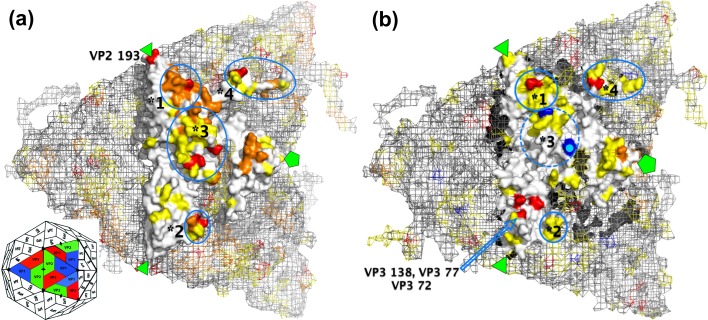
Antigenic sites on serotypes O and SAT1.The molecular surface of (a) serotype O and (b) serotype SAT1 icosahedral protomers is shown using pymol (Schrödinger LLC), with the molecular surface of neighbouring protomers shown as a light grey mesh (refer to inset icosahedral representation of an FMDV capsid for orientation). The molecular surface is white, with known antigenic sites on this serotype in orange (red when they were identified in this study), and known antigenic sites for any other serotype in yellow (see Table 1 and S3 Table for details). The location of the residues on the VP1 βG-βH loop could not be resolved on the serotype SAT1 structure, and so sites on that loop are not shown. Blue highlights mark the beginning (VP1 139) and end (VP1 165, with pale dot) of the disordered area, and the approximate locations of all four surface-exposed regions identified in Table 1 are also circled in blue and marked as before with *1-*4. Residues identified in this study but not in these regions are individually labelled with their positions on the common alignment. The three-fold and five-fold axes of symmetry are shown by triangles and pentagons respectively.